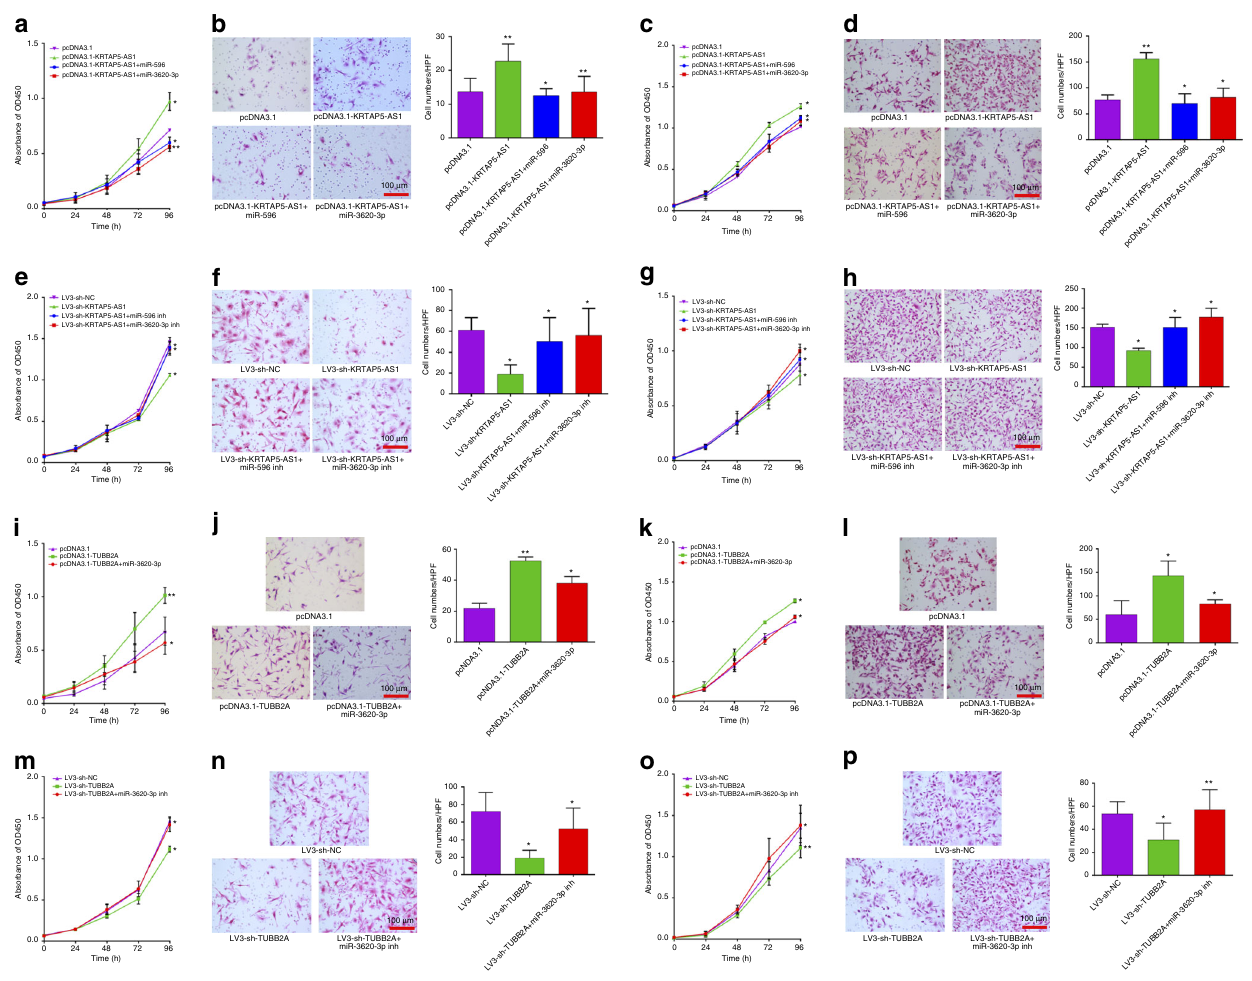
Fig. 5 LncRNA-KRTAP5-AS1 and lncRNA-TUBB2A enhance the proliferative and invasive capacity of GC cells in vitro. a Cell proliferation was assessed daily for 4 days using the CCK-8 assay in lncRNA-KRTAP5-AS1 overexpressing SGC-7901 cells. b Transwell assays were used to evaluate the involvement of lncRNA-KRTAP5-AS1 for invasion in lncRNA-KRTAP5-AS1 overexpressing SGC-7901 cells. c Cell proliferation assessed in lncRNA-KRTAP5-AS1 overexpressing AGS cells. d Transwell assays assessed in lncRNA-KRTAP5-AS1 overexpressing AGS cells. e Cell proliferation assessed in lncRNA- KRTAP5-AS1 knockdown SGC-7901 cells. f Transwell assays assessed in lncRNA-KRTAP5-AS1 knockdown SGC-7901 cells. g Cell proliferation assessed in lncRNA-KRTAP5-AS1 knockdown AGS cells. h Transwell assays assessed in lncRNA-KRTAP5-AS1 knockdown AGS cells. i Cell proliferation assessed in lncRNA-TUBB2A overexpressing SGC-7901 cells. j Transwell assays assessed in lncRNA-TUBB2A overexpressing SGC-7901 cells. k Cell proliferation assessed in lncRNA-TUBB2A overexpressing AGS cells. l Transwell assays assessed in lncRNA-TUBB2A overexpressing AGS cells. m Cell proliferation assessed in lncRNA-TUBB2A knockdown SGC-7901 cells. n Transwell assays assessed in lncRNA-TUBB2A knockdown SGC-7901 cells. o Cell proliferation assessed in lncRNA-TUBB2A knockdown AGS cells. p Transwell assays assessed in lncRNA-TUBB2A knockdown AGS cells. In b , d , f , h , j , l , n , p , cells were incubated for 24 h, and counted under the microscope. Original magni fi cation × 200. Scale bars = 100 μ m. Data are shown as mean ± s.d., n = 3. The data statistical signi fi cance is assessed by Student ’ s t -test. * P < 0.05, ** P <